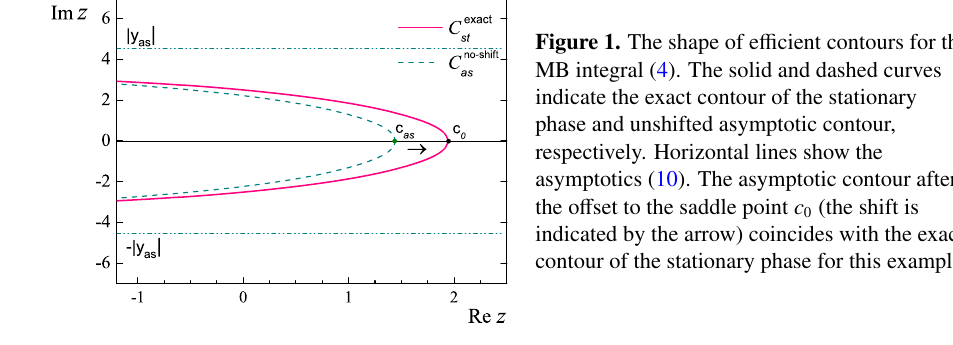
Figure 1. The shape of e ffi cient contours for the MB integral (4). The solid and dashed curves indicate the exact contour of the stationary phase and unshifted asymptotic contour, respectively. Horizontal lines show the asymptotics (10). The asymptotic contour after the o ff set to the saddle point c 0 (the shift is indicated by the arrow) coincides with the exact contour of the stationary phase for this